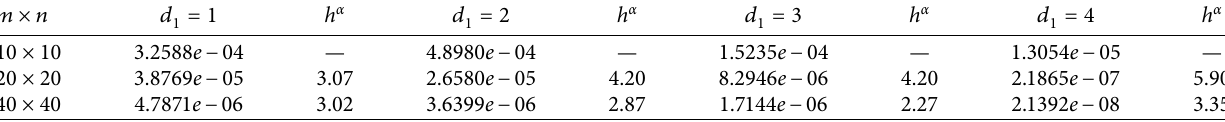
� 9 for Example 3. 2